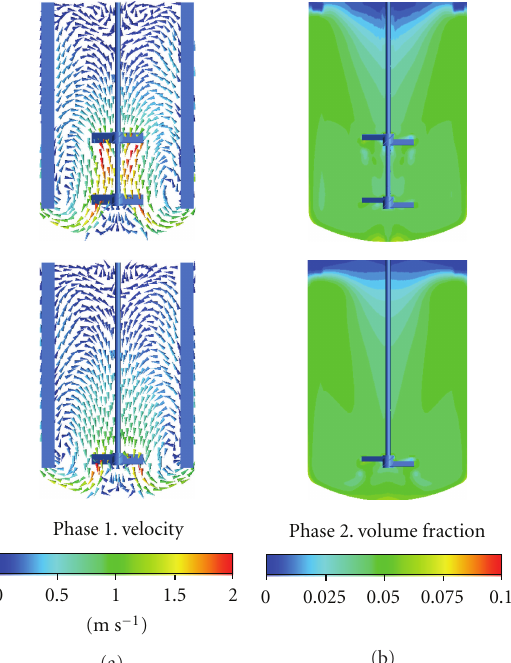
Figure 5: Contour plots for 400 RPM, 10% (w/w) loading for single- and dual-impeller configurations on a midplane. (a) Velocity vector of liquid phase. (b) Volume fraction of solid